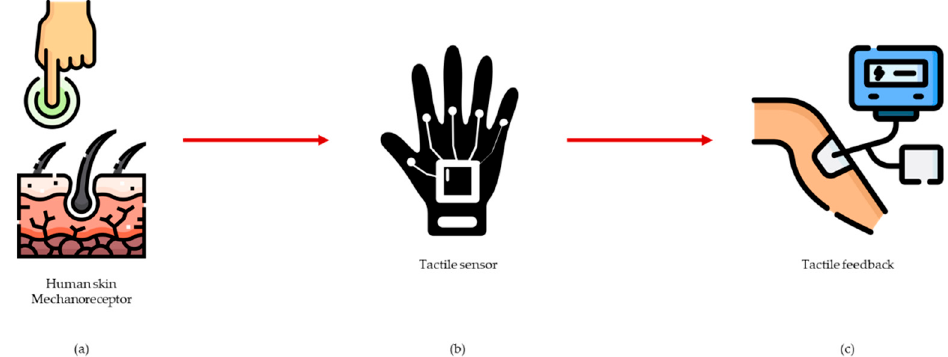
Figure 2. The proposed workflow of a haptic feedback system. ( a ) shows the tactile stimuli that is received by the mechanoreceptors, ( b ) the tactile sensor converts the same stimuli into data before ( c ) recreates the same feedback sensation.